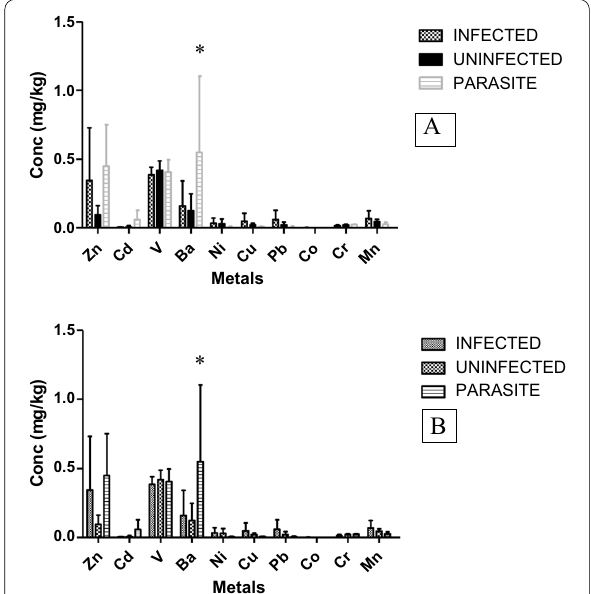
Fig. 1 Trace metals in the liver ( A ) and intestine ( B ) of T.